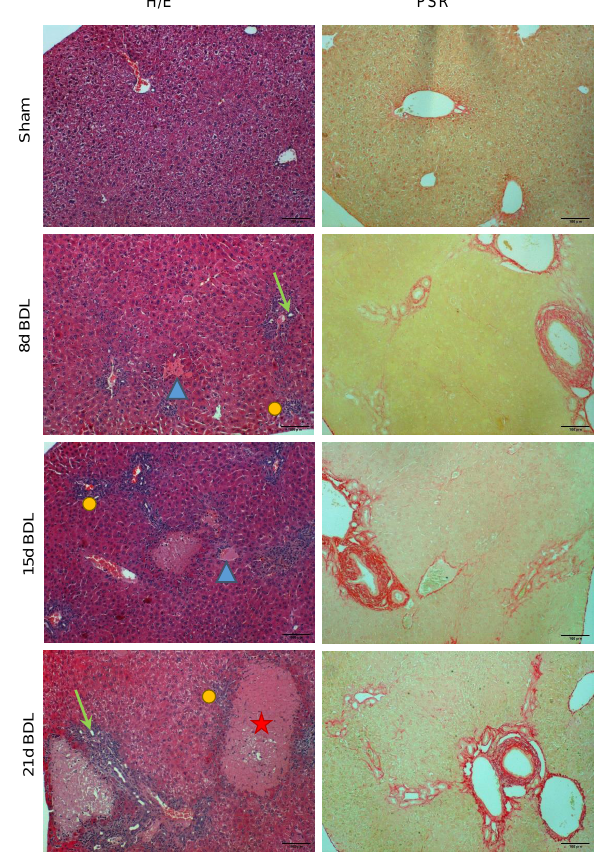
Figure 2. The typical appearance of liver tissue at representative time points after BDL with respect to sham controls is shown. Hematoxylin and eosin (H/E) and PicroSirius Red (PSR) staining reveal the tissue architecture and deposition of extracellular matrix (in red), respectively. The star shows necrotic areas, the arrowheads show bile infarct areas, the arrows show the artificial bile ductules formed, and the dots show inflammatory cell infiltrates. Images were taken at 10 × magnification. Scale bar: 100 µ m.